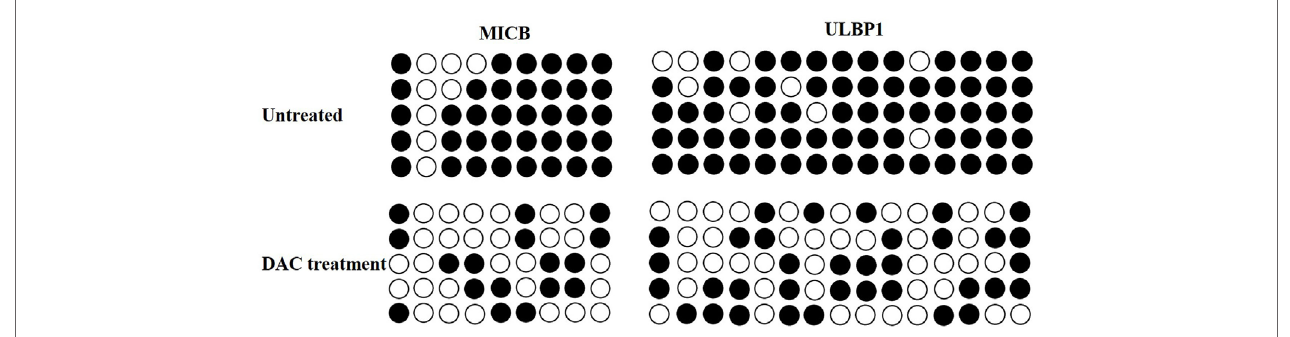
FigUre 4 | Decitabine (DAC) induces DNA demethylation at the MICB and UL16-binding protein 1 (ULBP1) promoter region. Cells were treated with 5 µM DAC for 3 days, and the methylation state of MICB and ULBP1 promoter was checked by bisulfite sequencing. Each circle represents a single CpG dinucleotide on the strand. Five clones from each cell line were analyzed. The open and filled circles represent the unmethylated and methylated CpG islands,